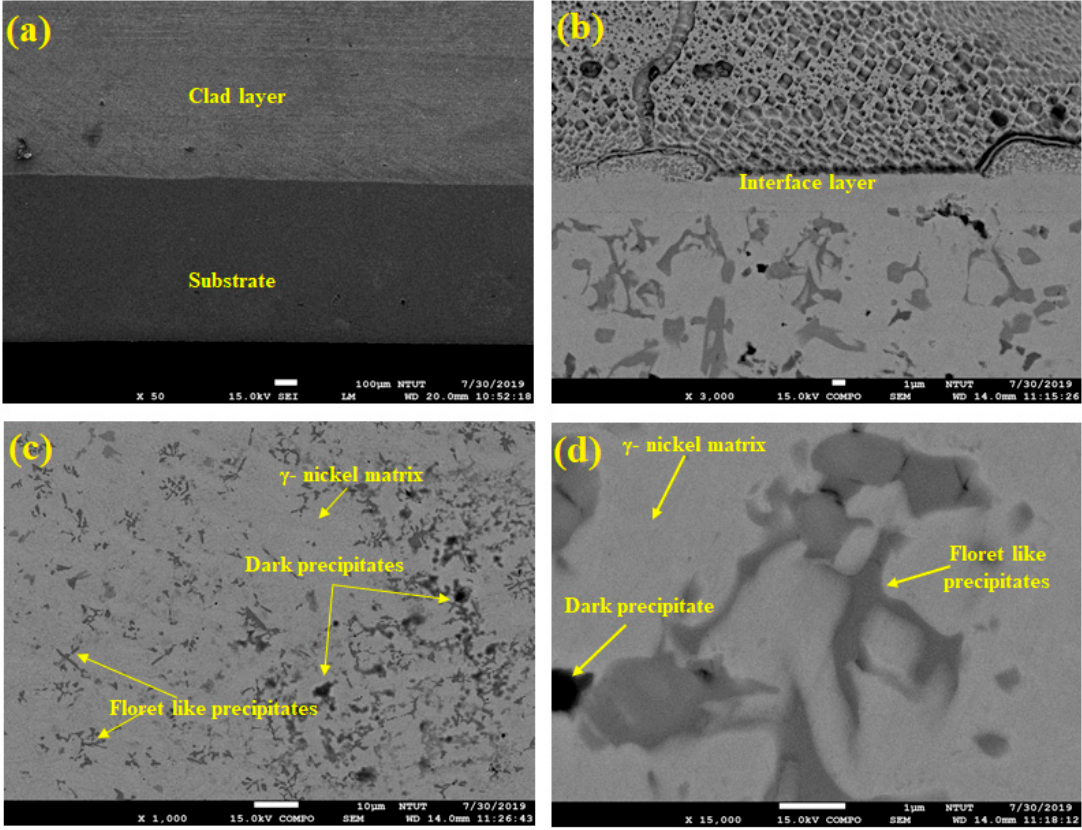
Figure 3. FESEM image of ( a ) Cladded sample, ( b ) Magnified view of the cladded sample, ( c ) Clad region, and ( d ) Magnified view at the clad region representing the dark and floret like precipitates.